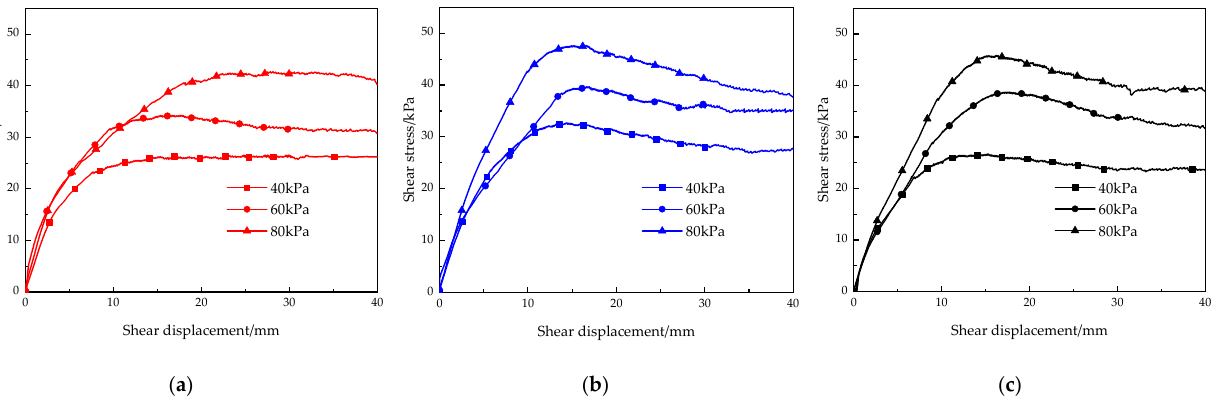
Figure 8. Shear displacement-shear stress curve of the reinforced soil interface under a nonfrozen state (0 °C): ( a ) 2% water content; ( b ) 4.5% water content; ( c ) 7% water content.